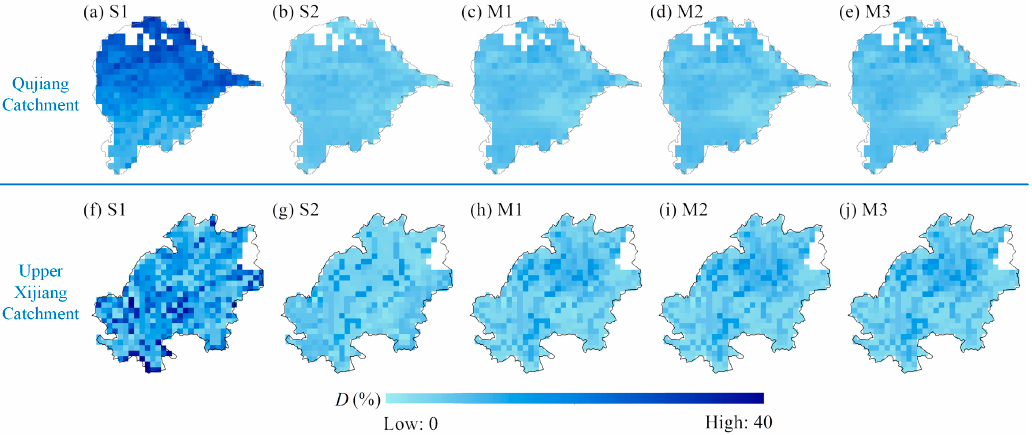
Figure 12. Gridded Transformed Average Bandwidth ( TB ) for 90% confidence limits of total predictive uncertainty for SM (%) in multiple scenarios (S1–S2, M1–M3) during the validation period in Qujiang catchment ( a – e ) and Upper Xijiang catchment ( f – j ).